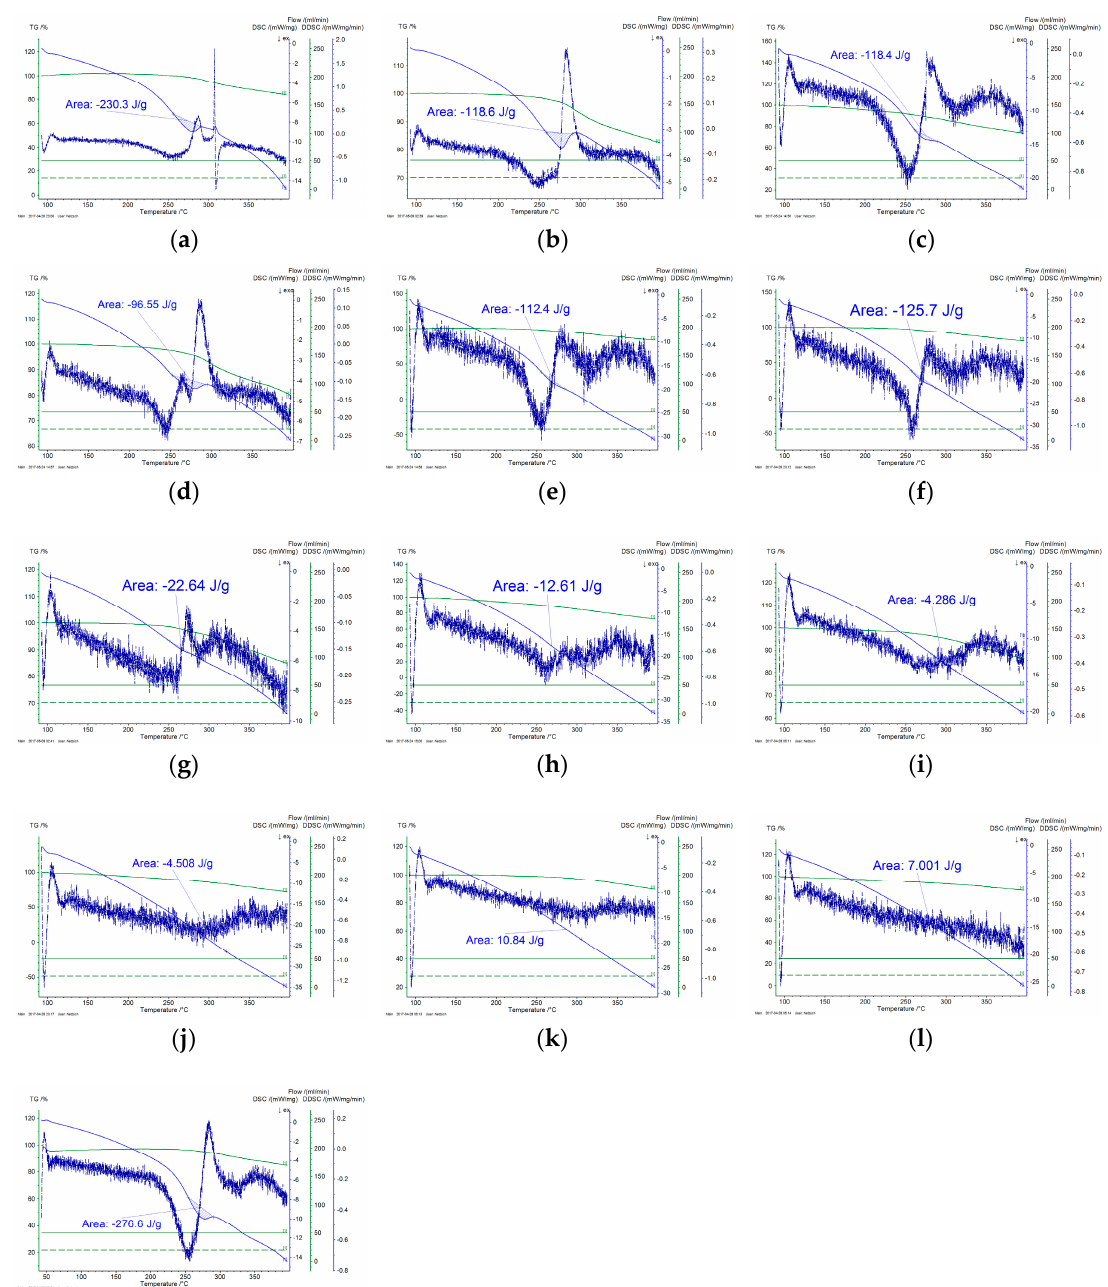
Figure A1. DSC-TGA-DTG analysis of PAN fibers stabilized ( a ) 160 ◦ C, ( b ) 170 ◦ C, ( c ) 180 ◦ C, ( d ) 190 ◦ C,